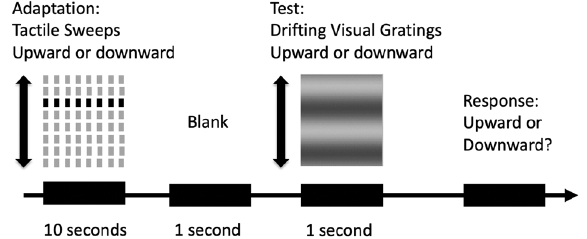
Figure 3. The experimental procedure in the tactile-to-visual condition. In each trial, 20 successive tactile sweeps, all going either upward or downward, were delivered to participants’ index fingertip of the right hand for 10 s, followed by 1 s blank and then a target visual grating drifting for 1 s. Participants were asked to judge the motion direction of the drifting grating and press “U” for upward motions and “D” for downward